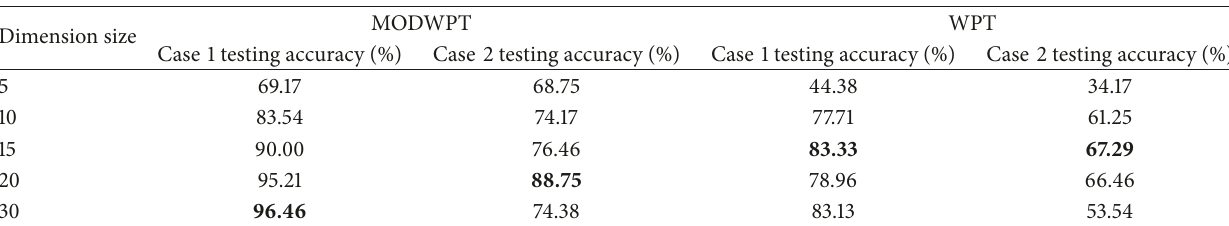
Table 5: Bearing fault diagnosis results obtained by OFS-NPE-SVM.